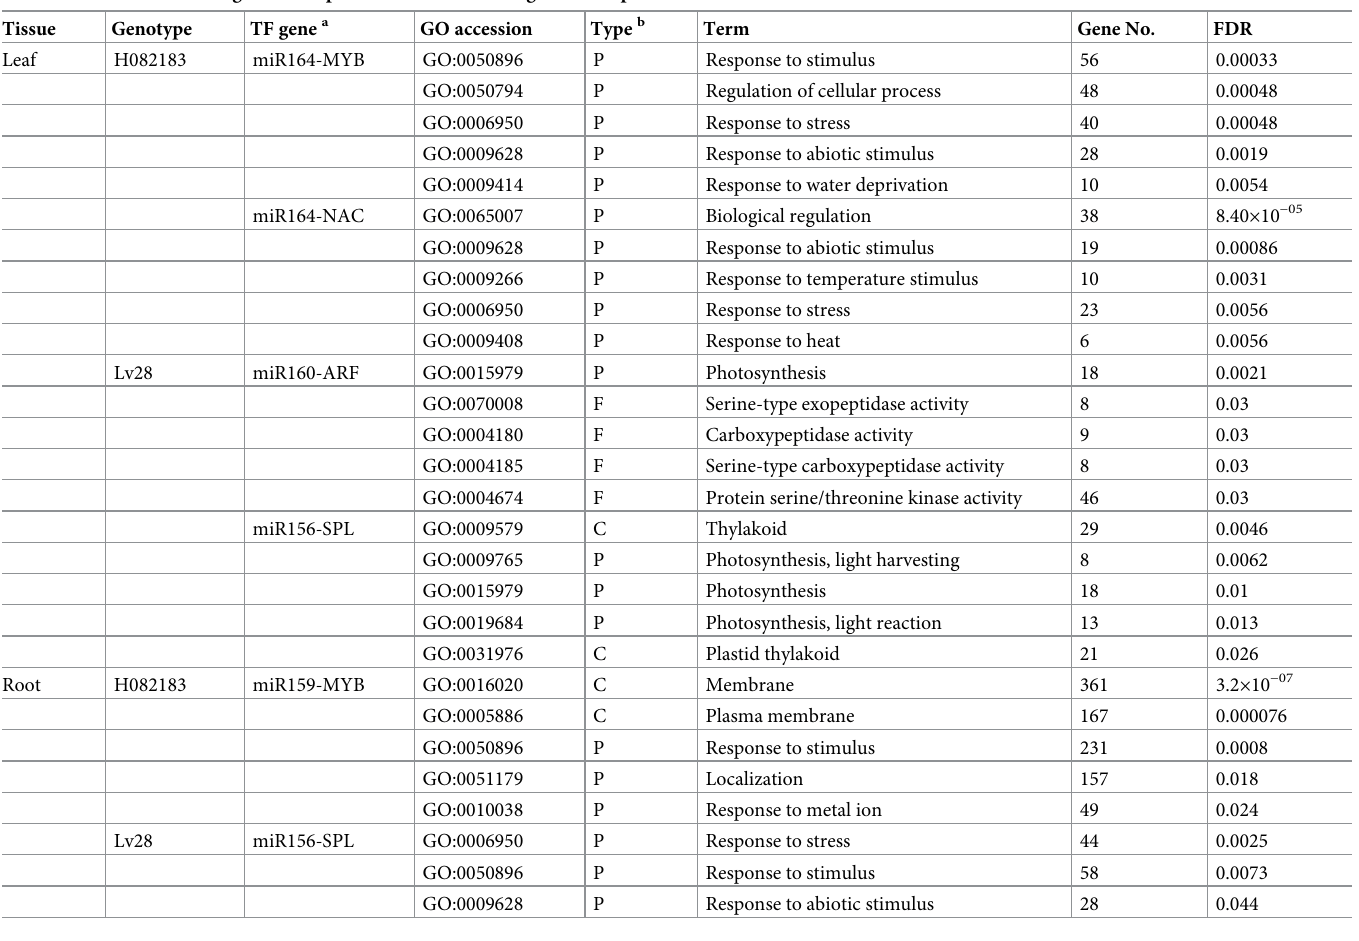
Table 1. GO enrichment of genes co-expressed with miRNA target transcription factors. Tissue